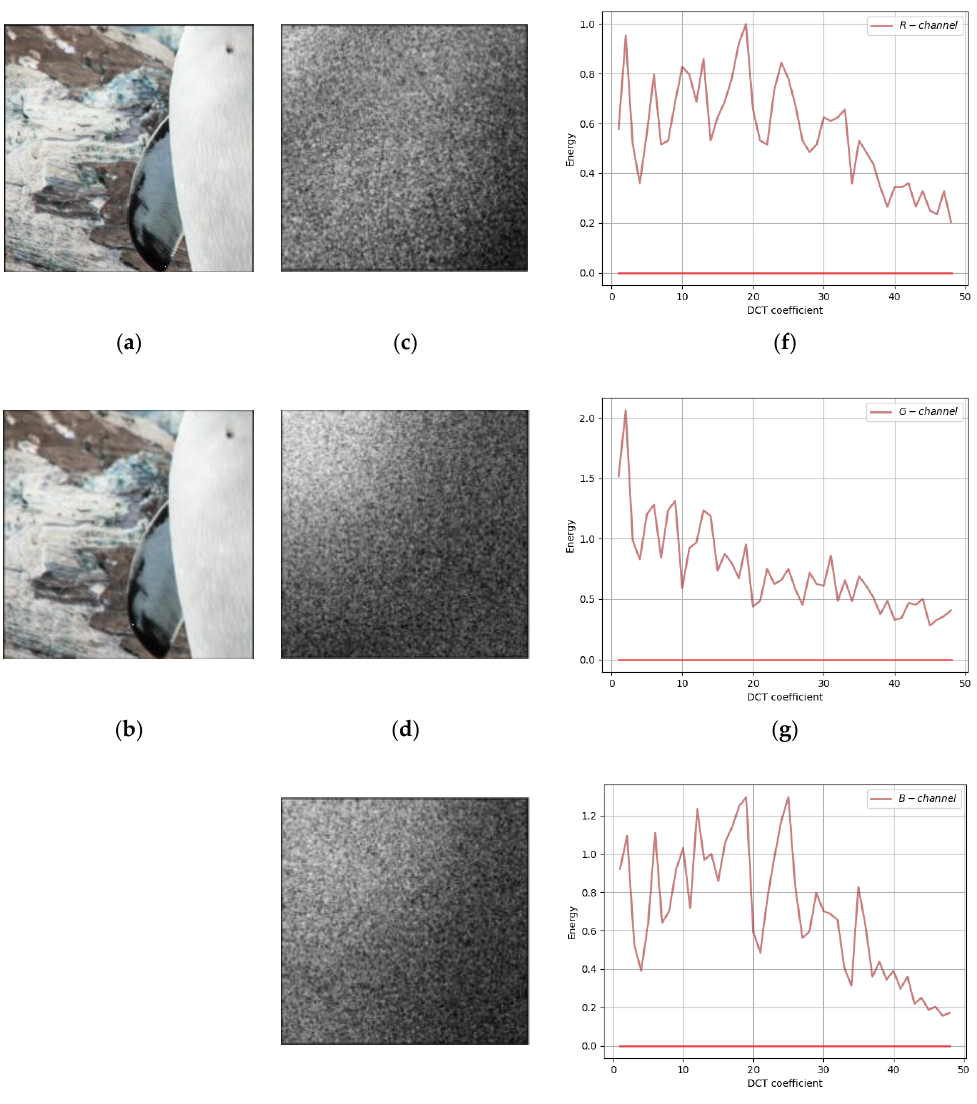
Figure 9. A frequency-domain residual analysis of our method. ( a ) Cover Image; ( b ) Steganographic Image; ( c ) R-channel DCT Domain Residual; ( d ) G-channel DCT Domain Residual; ( e ) B-channel DCT Domain Residual; ( f ) R-channel DCT residual curves; ( g ) G-channel DCT residual curves; ( h ) B-channel DCT residual curves.